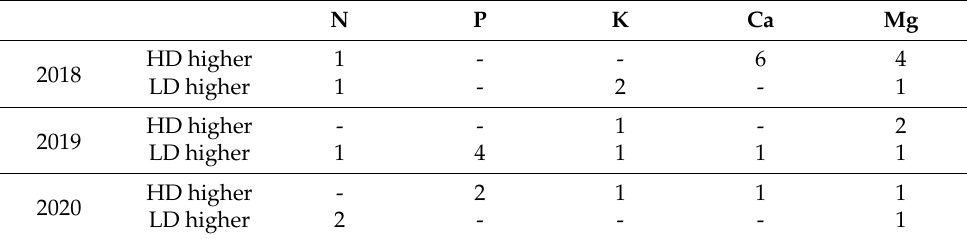
Table 2. Number of plots with significantly higher foliar concentrations in each defoliation category within sampling years determined by the independent samples t -test (total number of plots: 28).